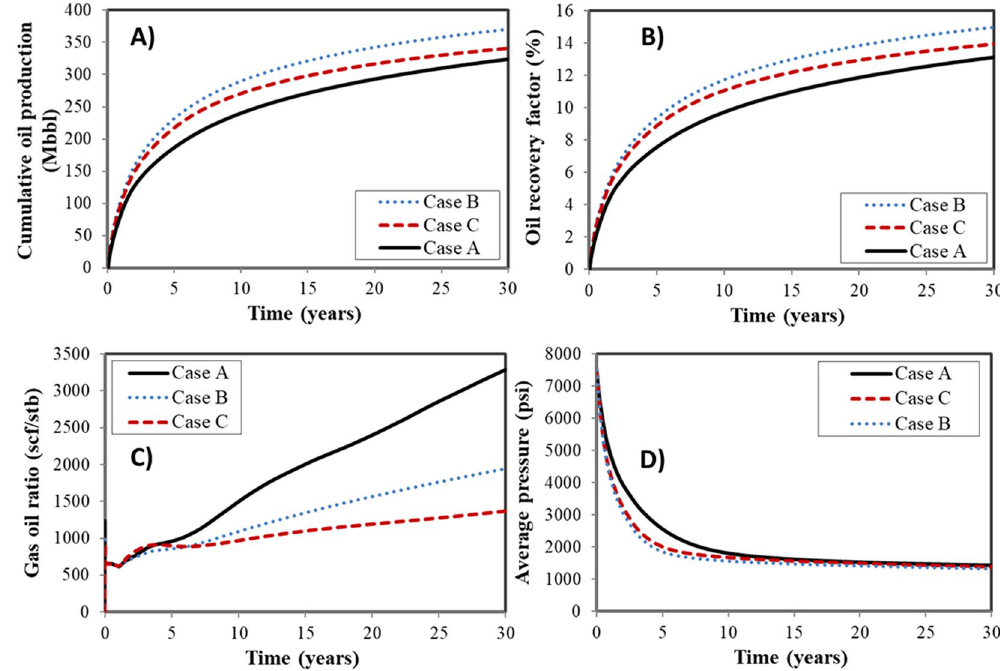
Figure 9. Well production of three cases in a 30-year period. ( A ) Cumulative oil production. ( B ) Oil recovery factor. ( C ) Gas oil ratio. ( D ) Average pressure.